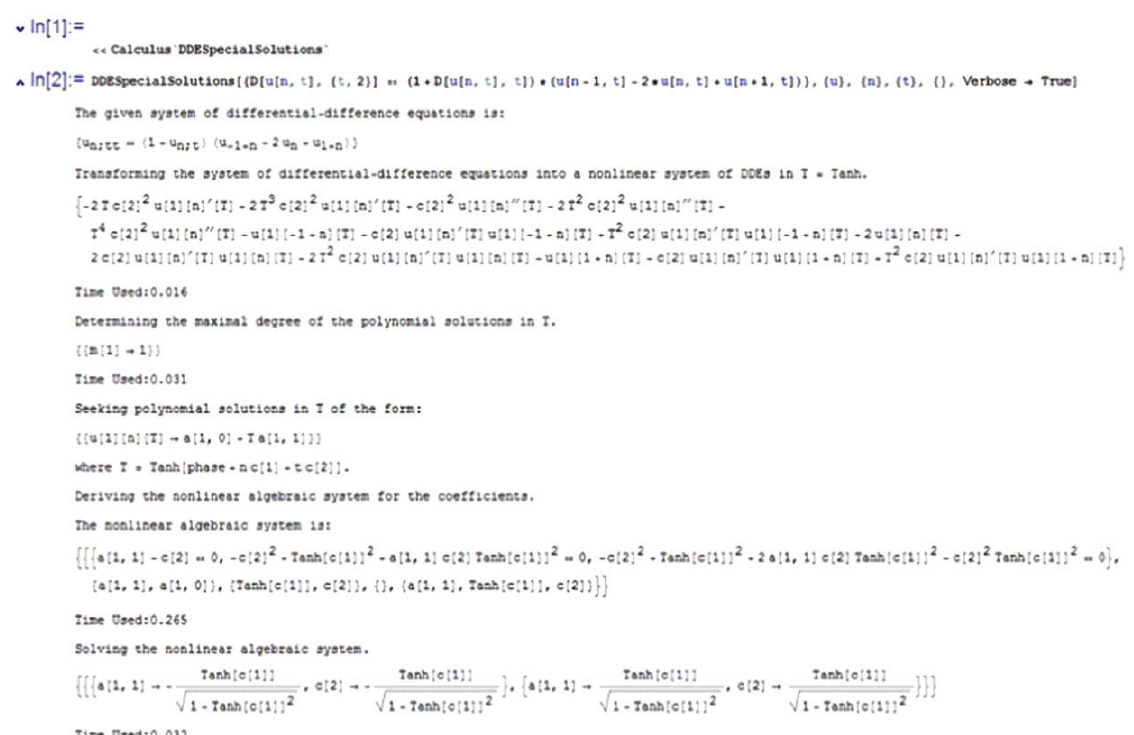
Figure 13 Single Toda lattice DDE equation by using Mathematica ® : first steps of the tanh-method.